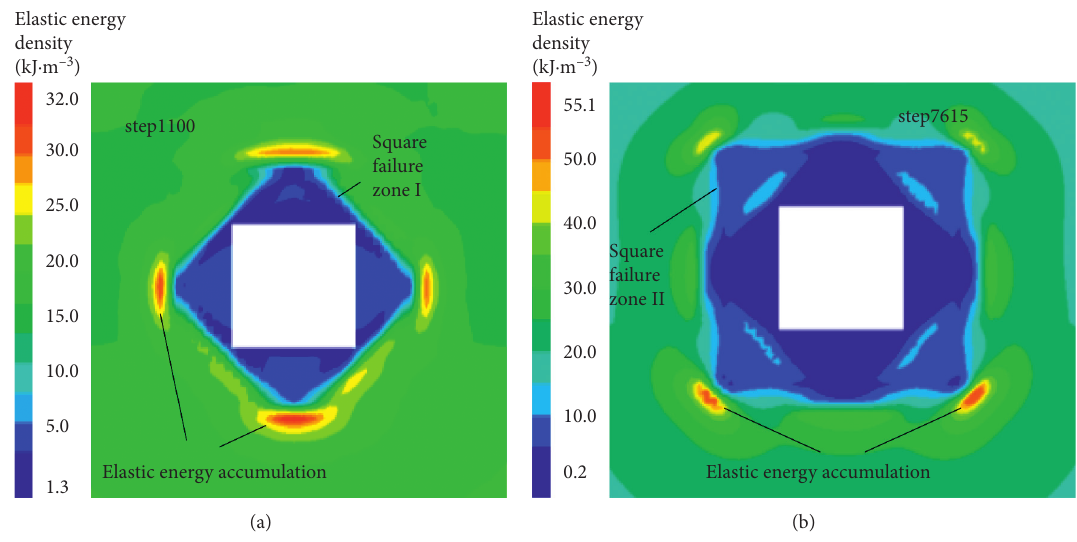
Figure 8: Evolution of elastic energy density of surrounding rock.